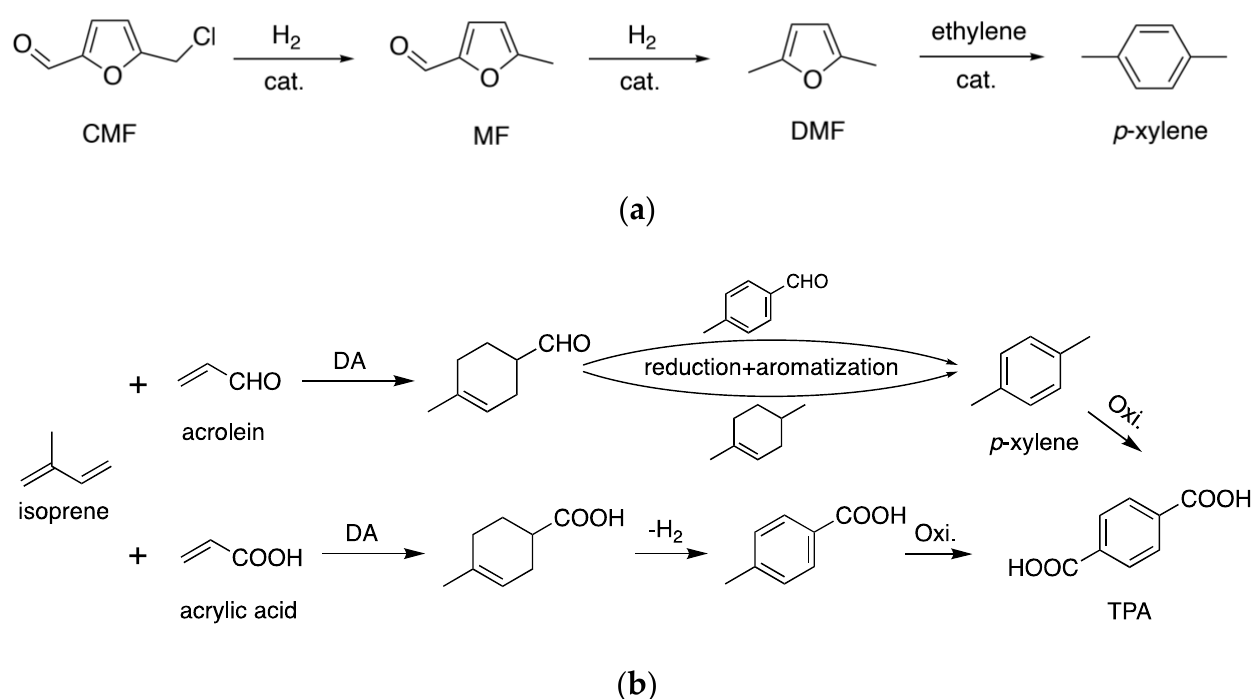
Figure 7. Chemical pathways to produce p-xylene: ( a ) from CMF to p-xylene and ( b ) from isoprene to p-xylene or TPA (complied from refs. [119,134,137]).